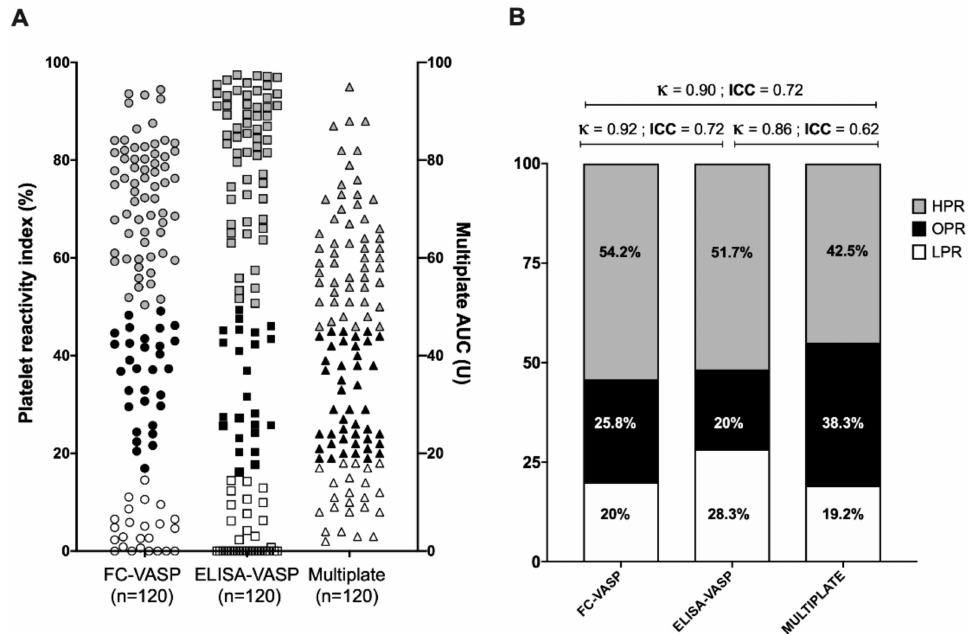
Figure 4. ( A ) Classification of individual samples into high, optimal, and low platelet reactivity. Analysis is based on cut-o ff s of < 19, 19–46, and > 46 U for the Multiplate ® analyzer and of < 16, 16–50, and > 50% for the VASP assays for low, optimal, and high platelet reactivity (cut-o ff s based on Aradi et al. [4]). ( B ) Data expressed as proportion within the therapeutic window by the di ff erent platelet function